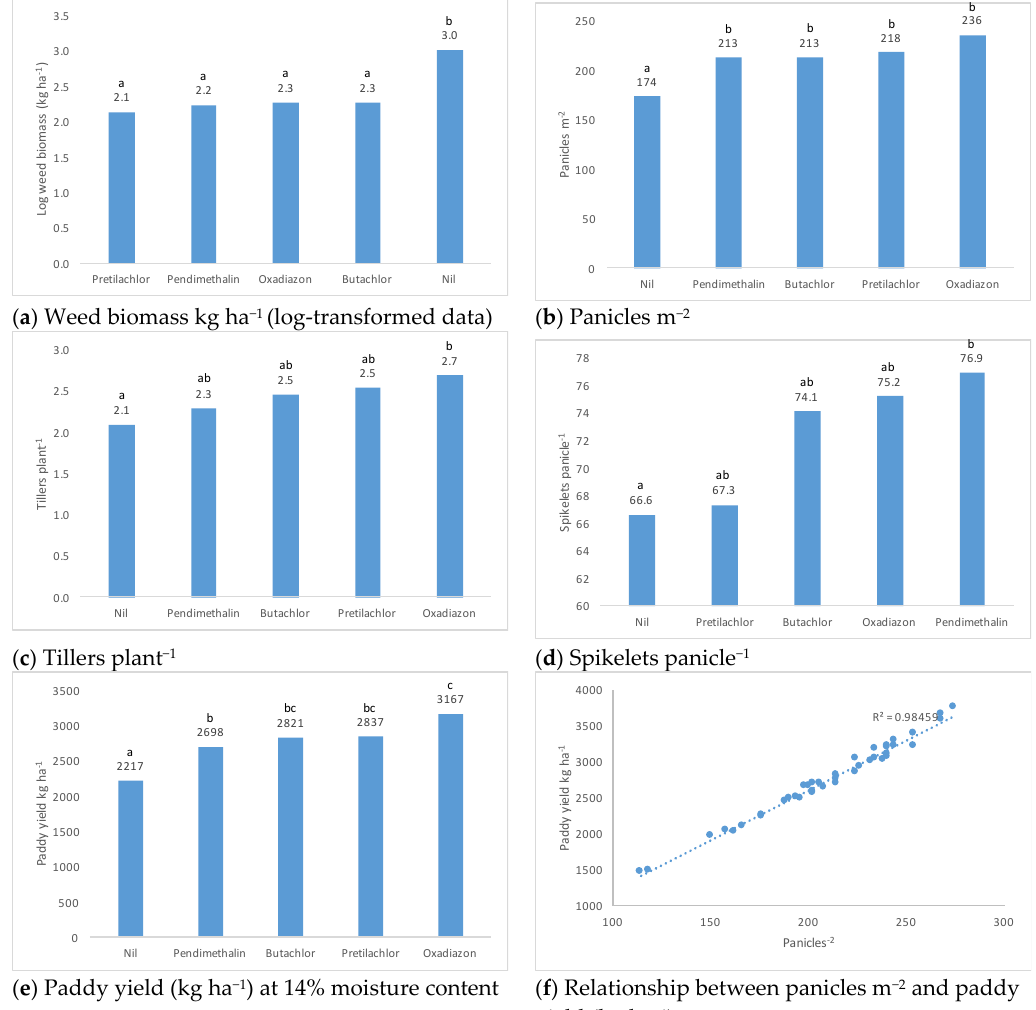
Figure 5. E ff ect of pre-emergence herbicides on rice yield components in 2018 (means that share the Figure 5. Effect of pre ‐ emergence herbicides on rice yield components in 2018 (means that share the same letter are not significantly di ff same letter are not significantly different).